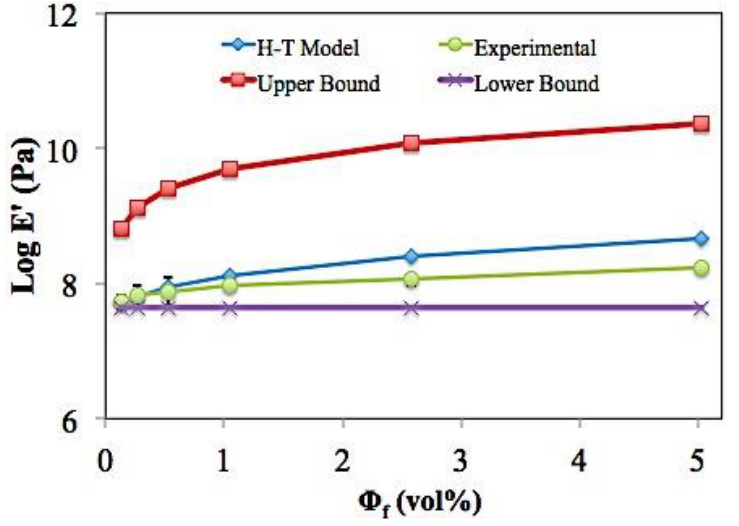
Figure 8. Comparison of the experimental storage modulus with those calculated by using the rule-of-mixture and Halpin – Tsai theoretical model, respectively.